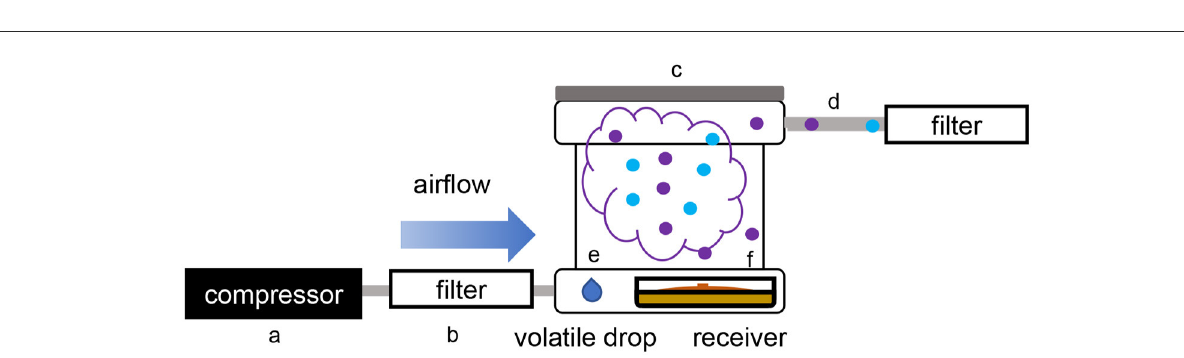
FIGURE2 Schematic overview of the single microcosm apparatus used for volatile exposure and collection. (a) Air compressor; (b) active charcoal filter; (c) PTFE box (microcosm); (d) PTFE pipe; (e) three drops of methanol containing the dissolved volatilome from the emitter strain; (f) glass Petri dishes containing the receiver